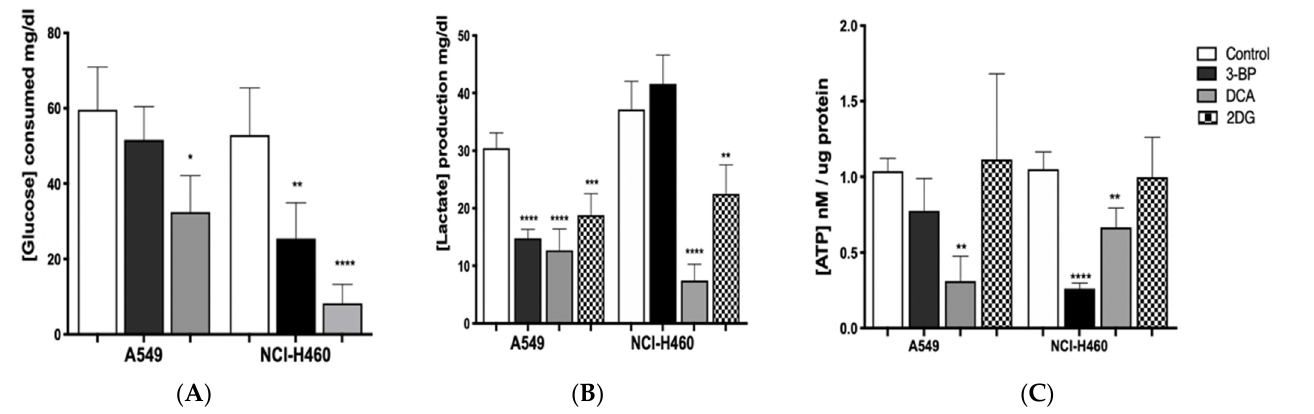
Figure 4. Metabolic profile of the lung cancer cell lines A549 and NCI-H460, estimated by ( A ) glucose consumption and ( B ) lactate and ( C ) ATP production, after treatment with GIs. Results are presented as means ± SEM, in triplicate, of at least three independent experiments. Significantly different between groups: * p < 0.05; ** p < 0.01; *** p < 0.001; **** p < 0.0001 compared to untreated cells (control).